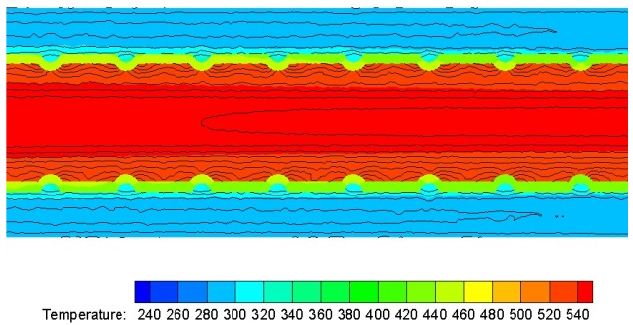
Figure 5. Temperature distribution.